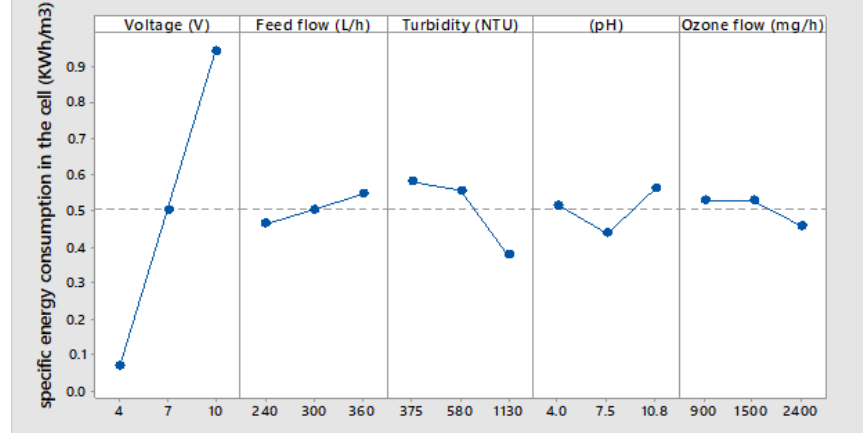
Figure 7. Effect of process parameters on specific energy